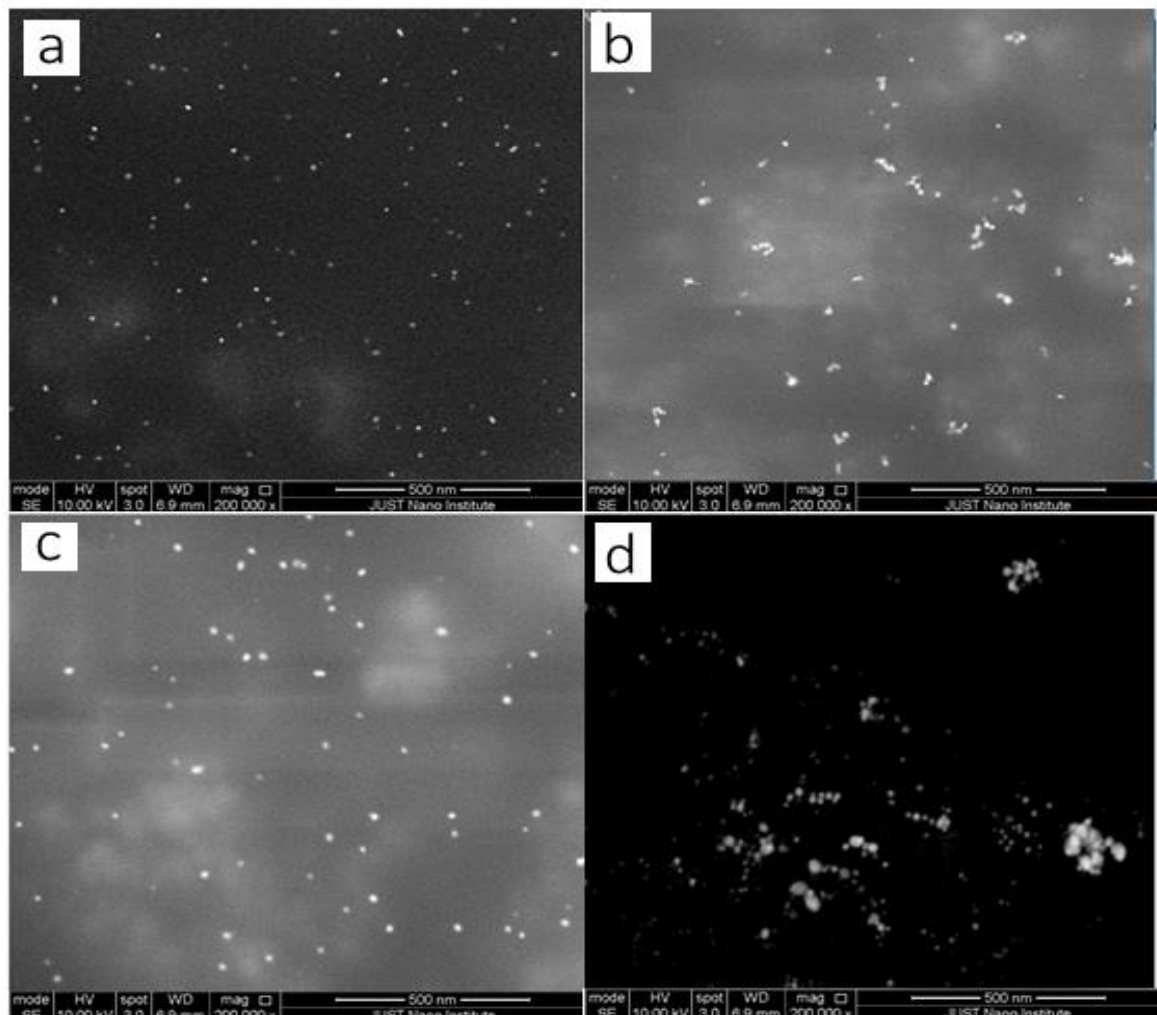
Figure 11. SEM images of the GNPs produced under different conditions. ( a ) GNPs made in a microreactor with a concentration of HAuCl 4 of 0.7 mM and in the presence of PVA (after 900 sec). ( b ) GNPs produced in a microreactor with a concentration of HAuCl 4 of 0.7 mM in the presence of PVA (after one year). ( c ) GNPs prepared with a conventional method with 0.7 mM HAuCl 4 in the presence of PVA (after 900 sec). ( d ) GNPs created using the conventional method with a HAuCl 4 concentration of 0.7 mM in the absence of PVA (after one year).